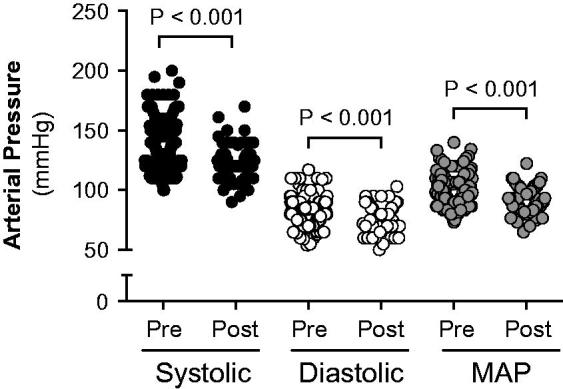
Systolic, diastolic, and mean arterial pressure (MAP) in hydronephrotic patients (n = 203; Male 47%; Female 53%) before (n = 203) and after (n = 60) surgical management of ureteropelvic junction obstruction.